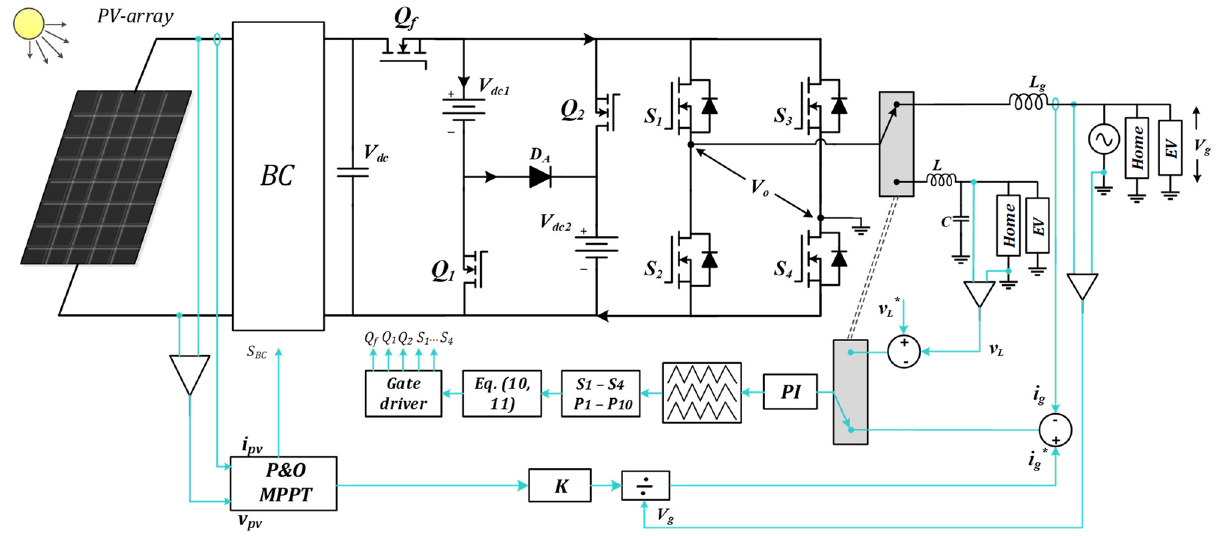
Figure 6. Control scheme of the grid connected PV system via the proposed 7-level inverter.